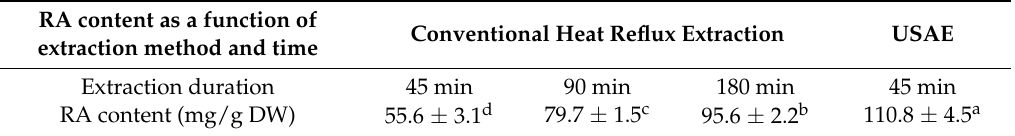
Table 6. Comparison between conventional heat reflux method and ultrasound-assisted extraction (USAE) of RA from P. scutellarioides